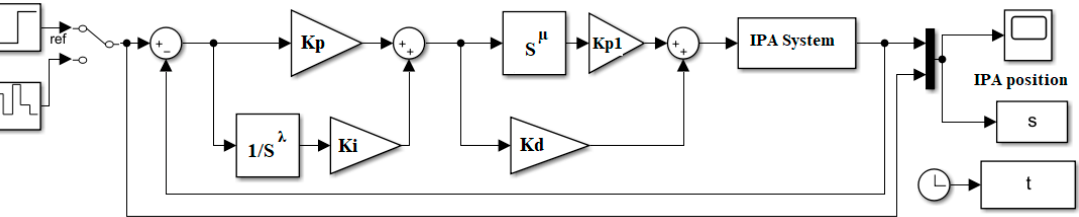
Figure 12. Simulink diagram for simulation CFOPID.